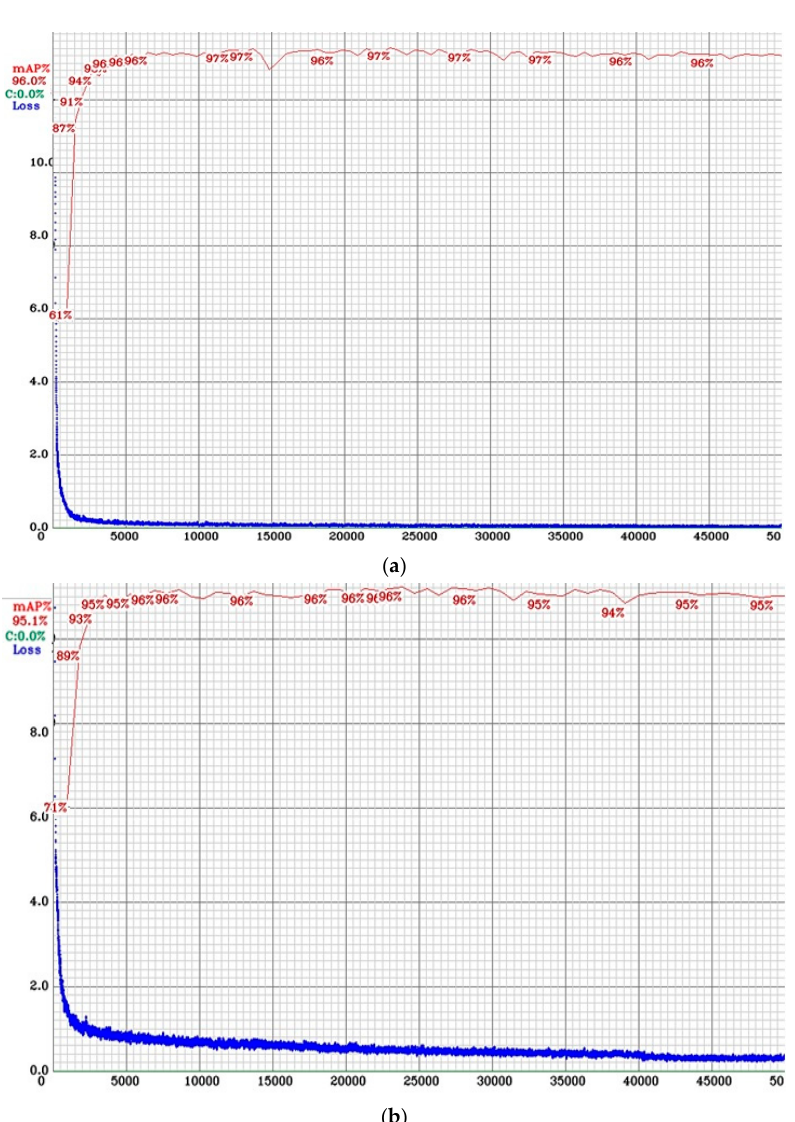
Figure 13. Accuracy and loss function of ( a ) numerical and ( b ) alphabetical characters in the printed dataset .